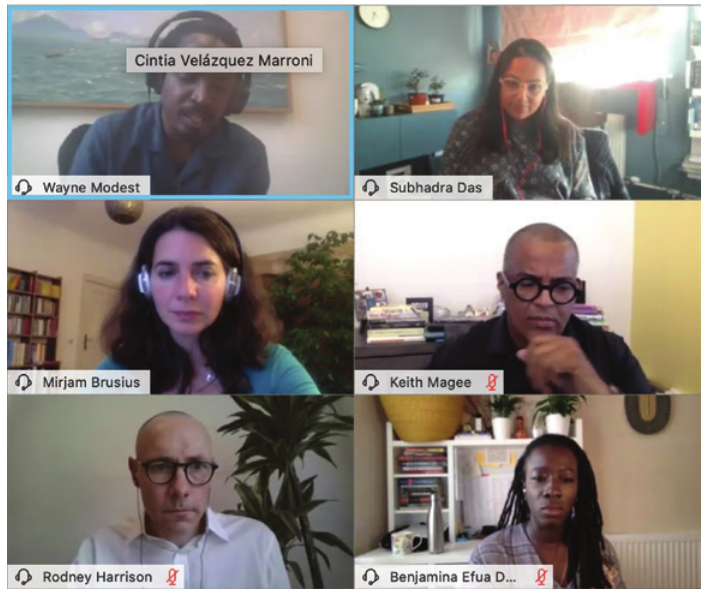
Figure 6 Screenshot of the online opening plenary panel of the Fifth Biennial Conference of the Association of Critical Heritage Studies (ACHS). (Image credit: Hana